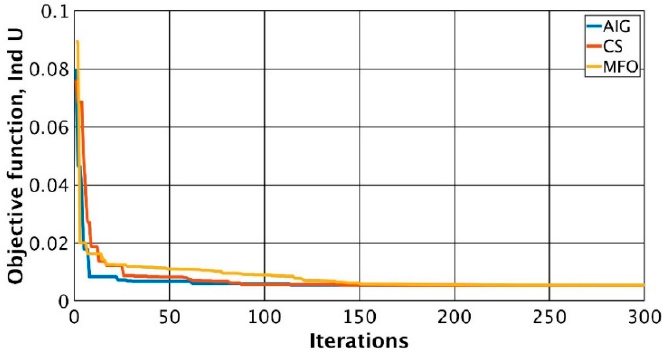
Figure 12. Changes of the best values of the objective function in subsequent iterations for AIG, CS and MFO